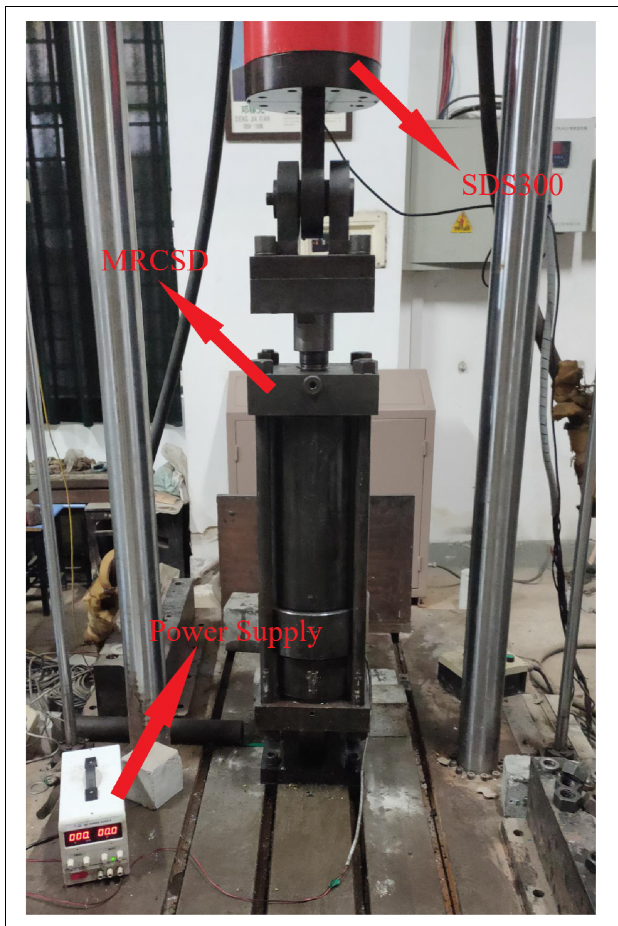
FIGURE 6 | Experimental device of the